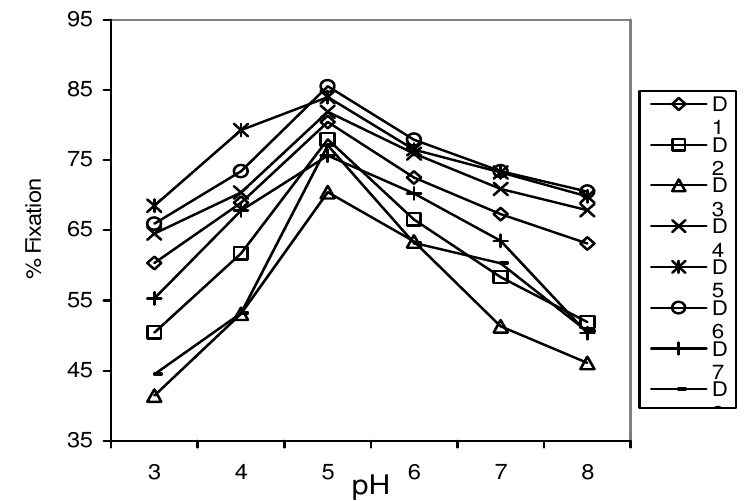
Figure 6. Effect of application pH on fixation